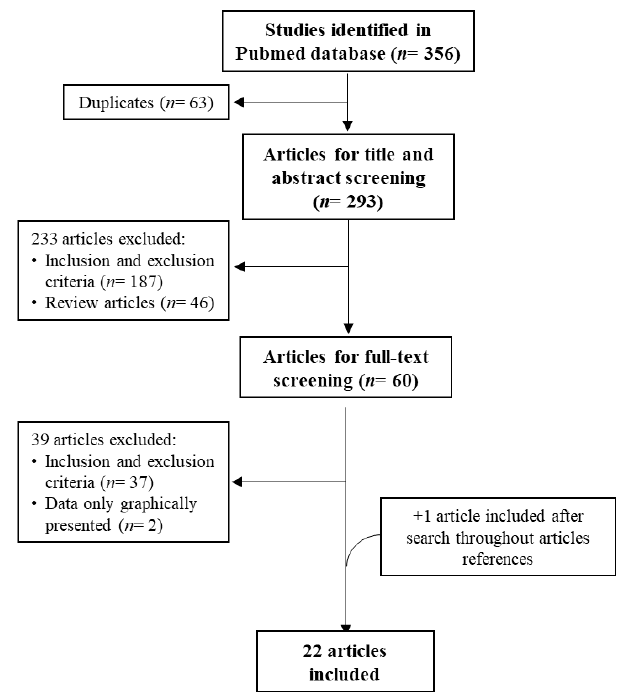
Figure 2. Flowchart of the selection process. Table 2. Occupational settings, exposure scenarios and median ( ± SD) exposure values for exposure biomarkers in urine reported in the selected studies ( n =